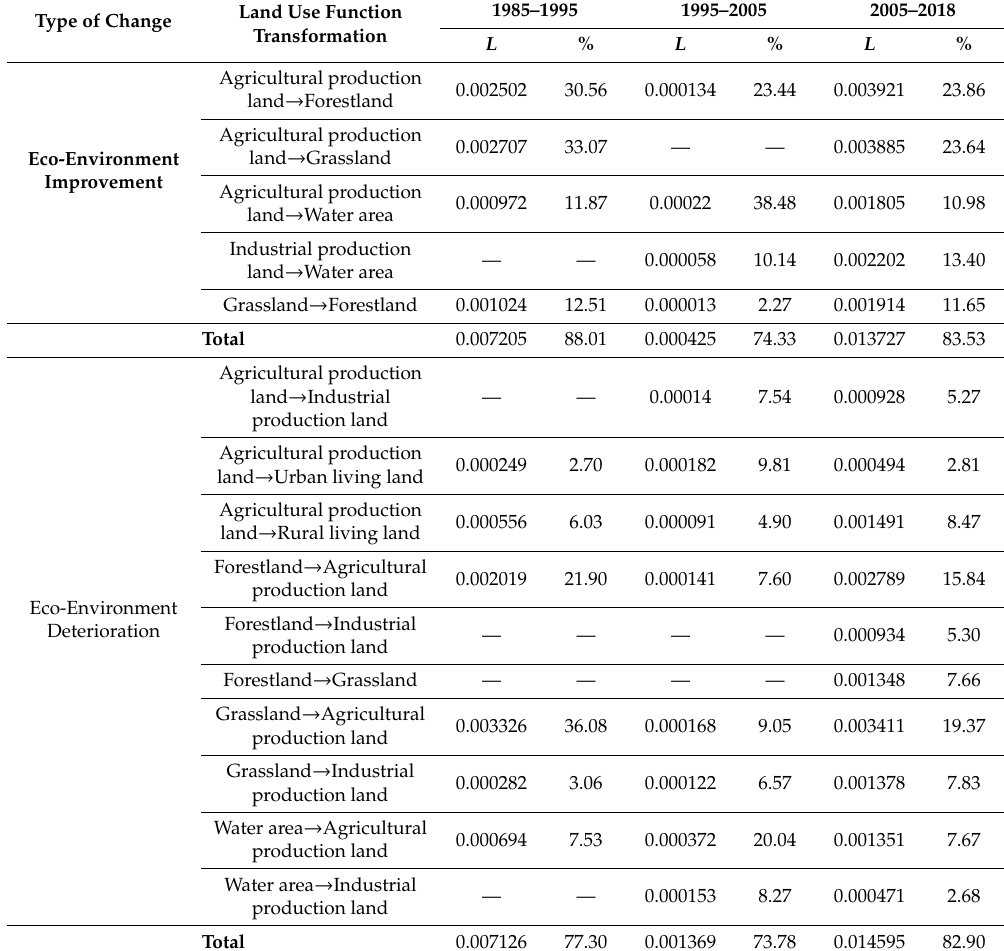
Table 5. Major land use changes and contributions a ff ecting the quality of the ecological environment in the BTH